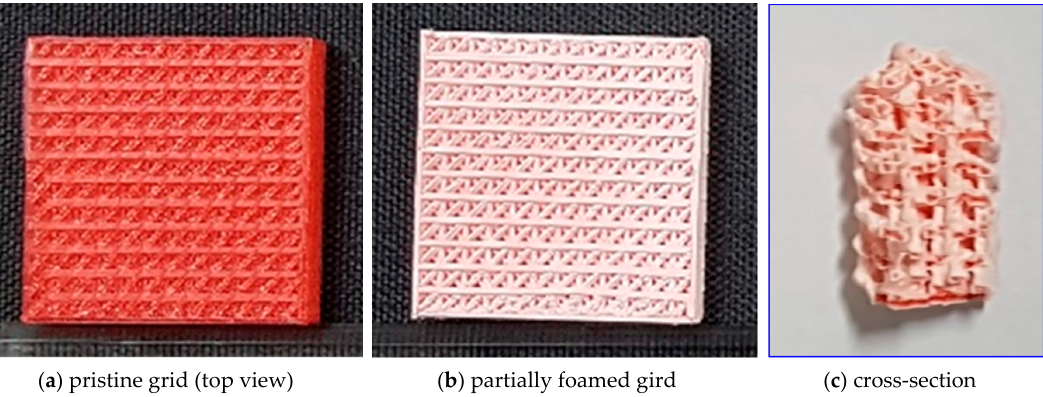
Figure 1. Typical 3D freeform structures shown as ( a ) printed, ( b ) post-foamed, and ( c ) cross-